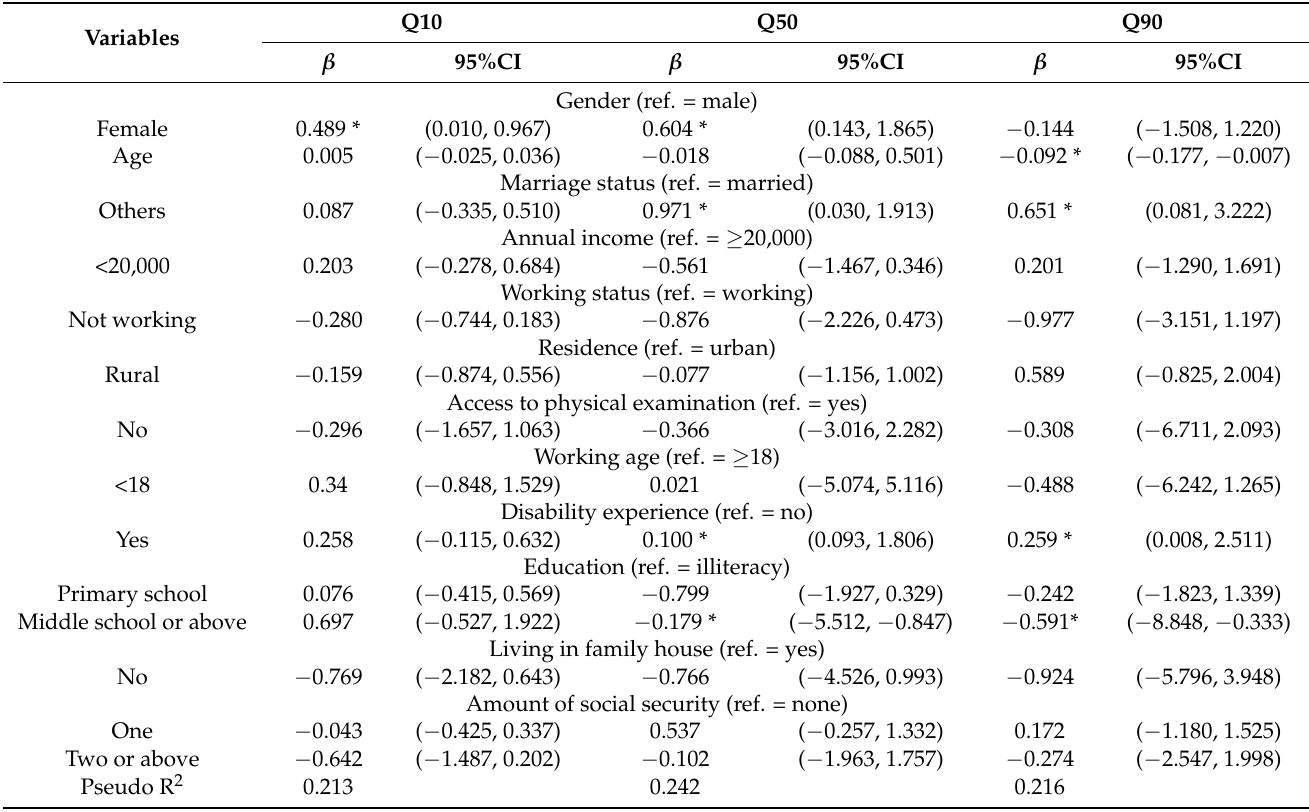
Table 3. Quantile regression results on the 10th, 50th, and 90th quantiles of depressive symptoms ( n =